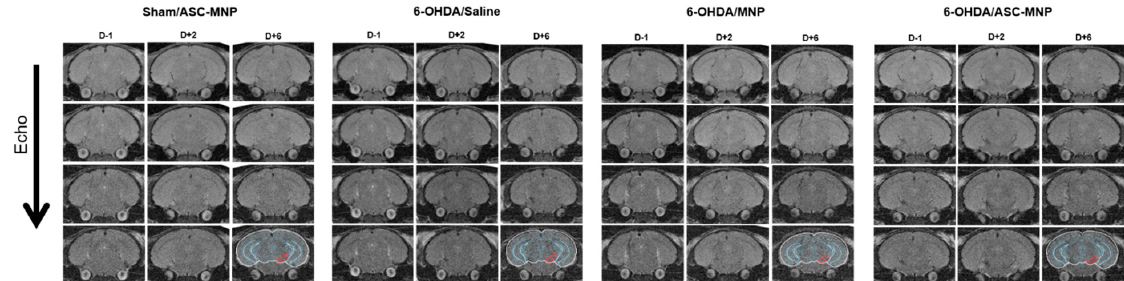
Figure 2. Sequential MR imaging was performed in mice injected with NEO-LIVETM-Magnoxide 797-labeled hASCs. MR images were acquired at optimized parameters on a 9.4 T Bruker animal imager at the indicated time points. MR imaging parameters were follows; Pulse sequence = Multiple Gradient Echo 2D, Echo train = 10, Selected image’s Echo train = 2, Echo spacing = 3 ms, Effective TE (Echo time) = 6 ms, TR (Repetition time) = 2000 ms, FA (Flip Angle) = 50 degree, Matrix